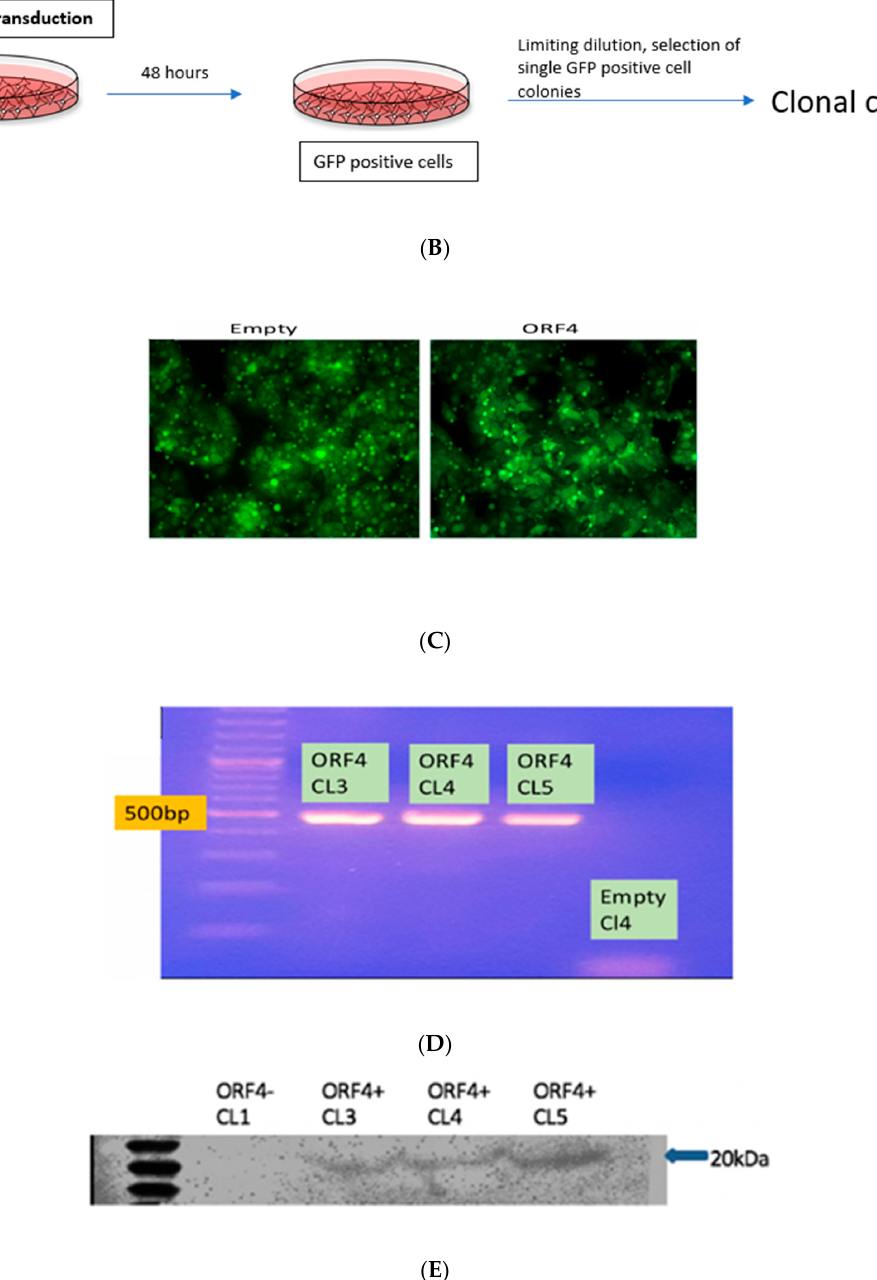
Figure 3. Lentiviral vector with ORF4 when transduced in Huh7 cell clones results in stable ORF4-expressing clones. ( A ) Schematic diagram of the lentiviral vector used with ORF4, GFP-tagged protein and promoter (T2A and P2A). ( B ) Workflow of lentiviral transduction in HEK293T cells. After 48 h of co-transfection using lipofectamine, cells were visualized for GFP expression. Supernatants were harvested and used to infect Huh7 S10-3 cells. Clonal cell lines were prepared using limiting dilution method. ( C ) Fluorescence microscope image illustrating GFP-positive cells which suggests the successful transduction of the lentiviral vector in both the cell lines (Empty = ORF4 − and ORF4 = ORF4+). ( D ) Agarose gel electrophoresis after RT-PCR utilizing ORF4 specific PCR primers indicates the presence of ORF4 RNA and absence of ORF4 RNA in the transduced Huh7 ORF4+ and ORF4 − cell clones, respectively. Each band represents ORF4 RNA of 500 bp. CL stands for clones that were formed after the limiting dilution. ORF4+ CL (3, 4, 5) represents the ORF4+ cell lines. ORF4 − CL 4 represents the ORF4 − cell line. ( E ) Western blots of Huh7 ORF4+ cell clones (3, 4, 5) and Huh7 ORF4 − cell clone 1 lysates transiently expressing the HEV ORF4 protein of 20 kDa. The blot was probed with goat anti-rabbit IgG, horse radish peroxidase to detect the expression of the HEV ORF4